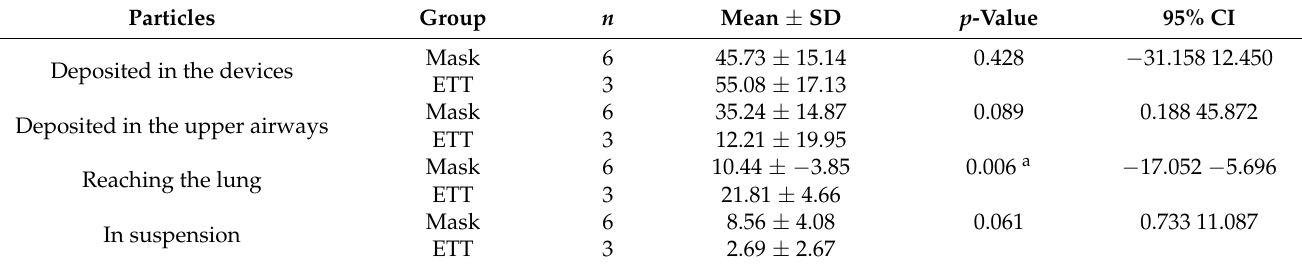
Table 5. Percentage of particle distribution and deposition comparing when using a mask or an ETT with or without a spacer. Particles Group Deposited in the